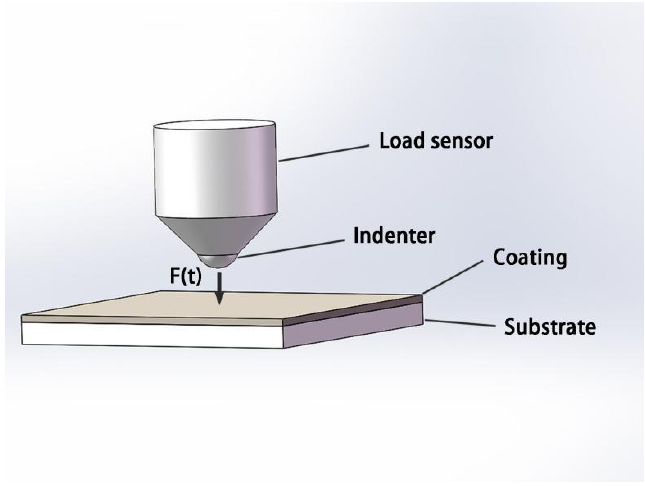
Table 3. Typical impact testing parameters.